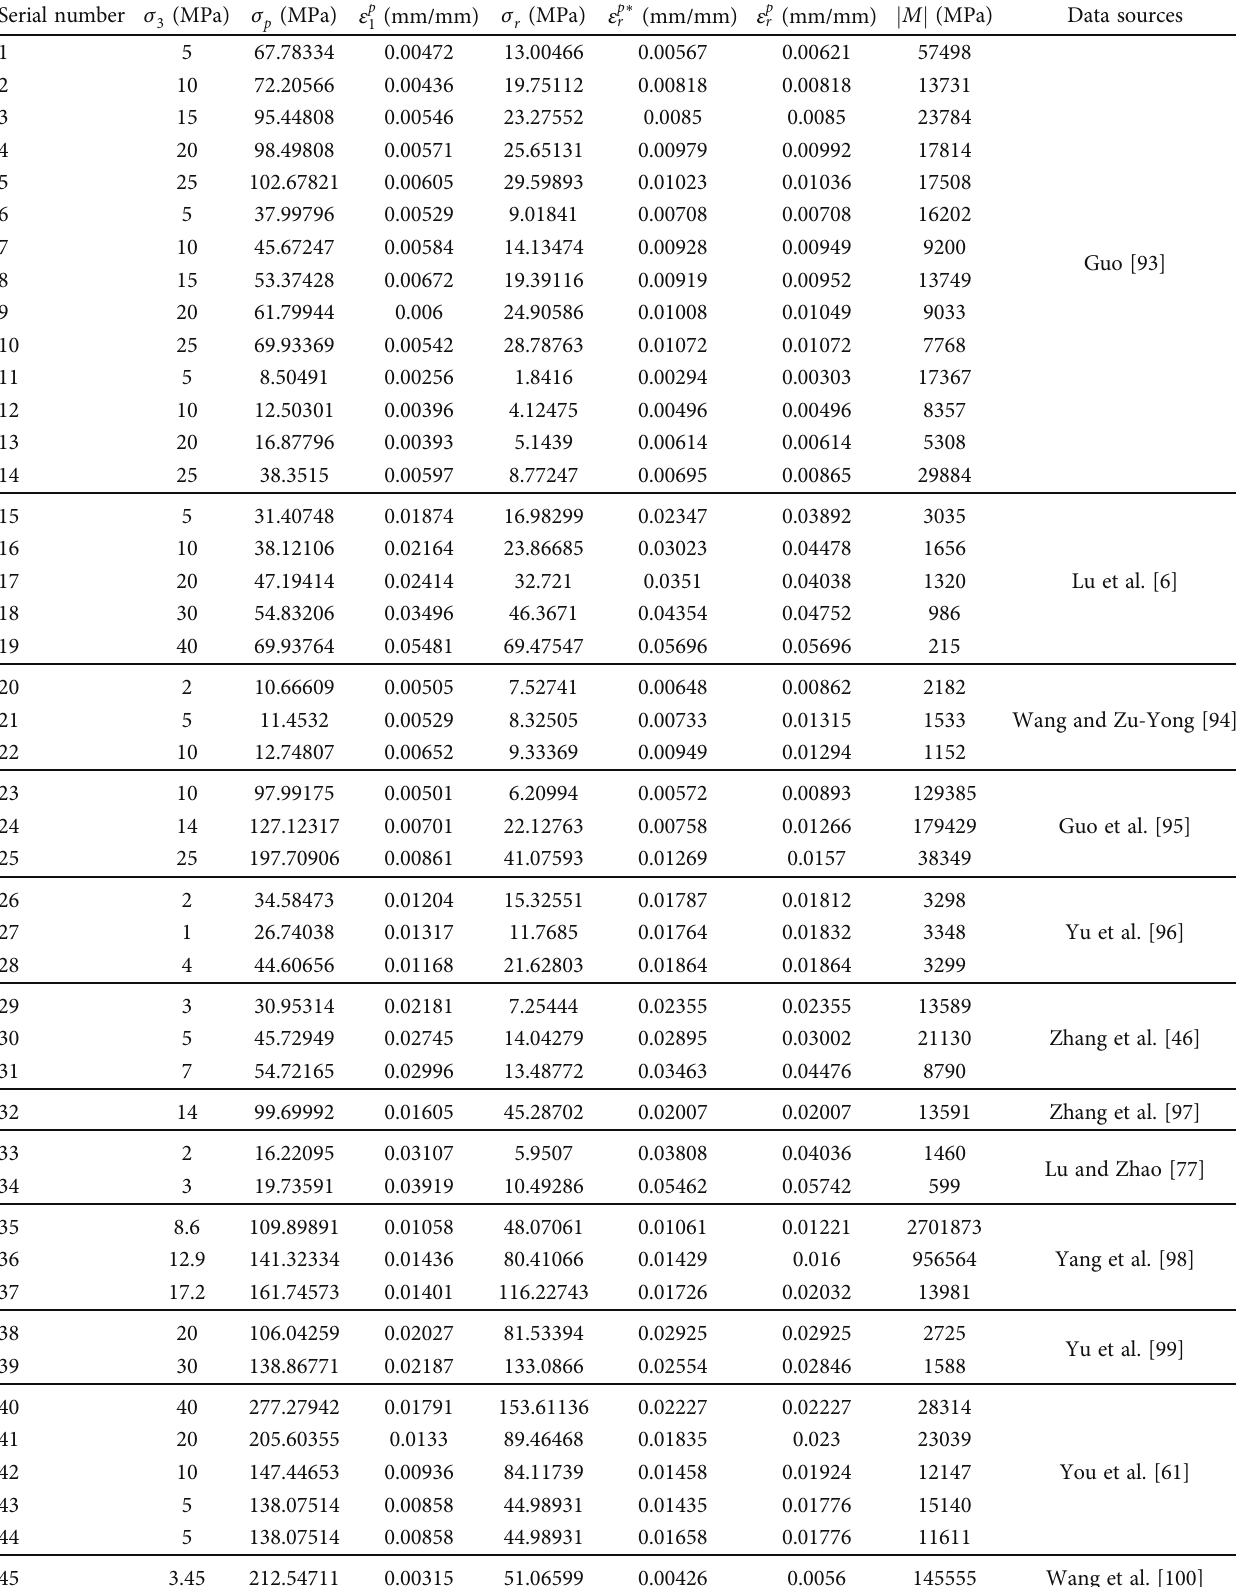
Table 5: Mechanical parameter statistics of complete stress-strain curves of soft rock during the triaxial